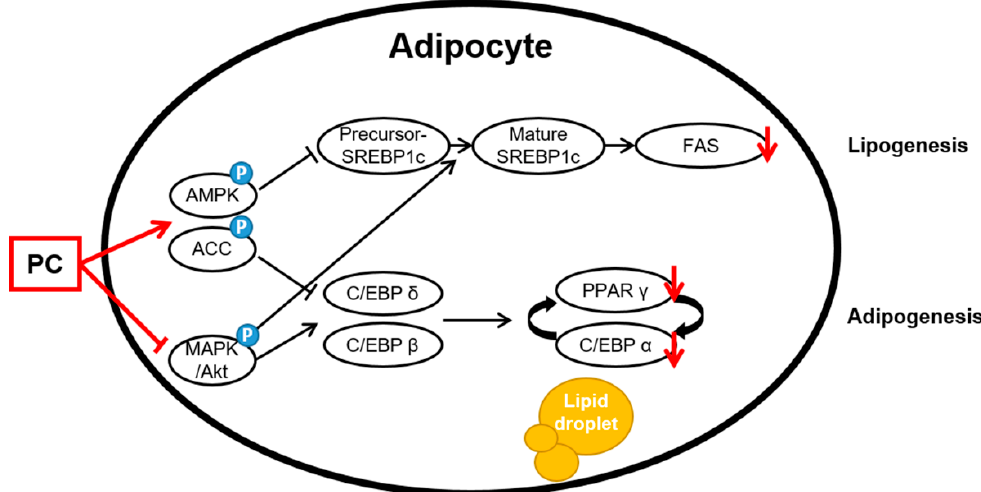
Figure 5. Schematic of the potential lipid mechanisms of PC in differentiated 3T3-L1 adipocytes. The anti-lipogenic and anti-adipogenic effects of PC are thought to be exerted via the suppression of the AMPK/ACC and MAPK/Akt pathways, thereby inhibiting adipogenic transcription factors and lipogenic proteins.